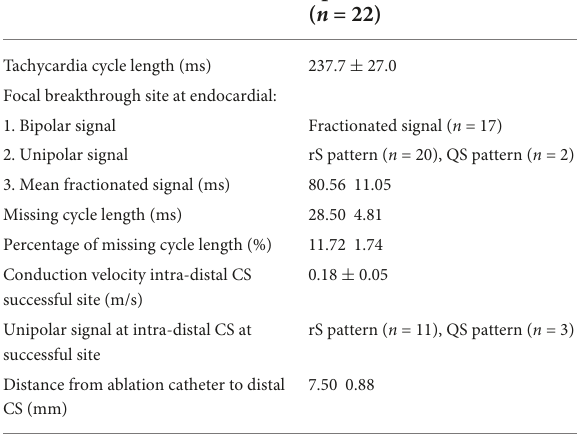
TABLE 2 Electrophysiological characteristics at epicardial successful site. Variable Epicardial successful site ( n = 22) Tachycardia cycle length (ms) 237.7 ±